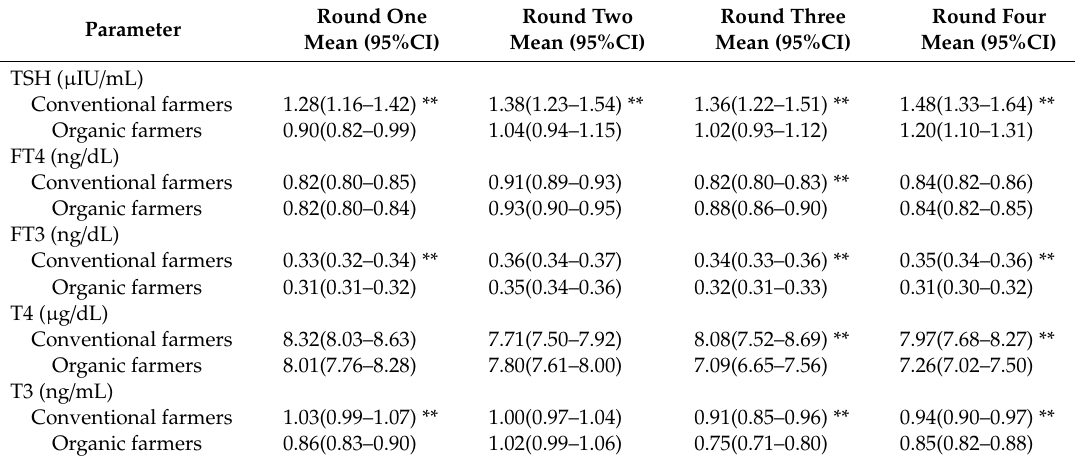
Table 3. Estimated Marginal Geometric Mean * of Thyroid hormones for each round of measurement for conventional and organic